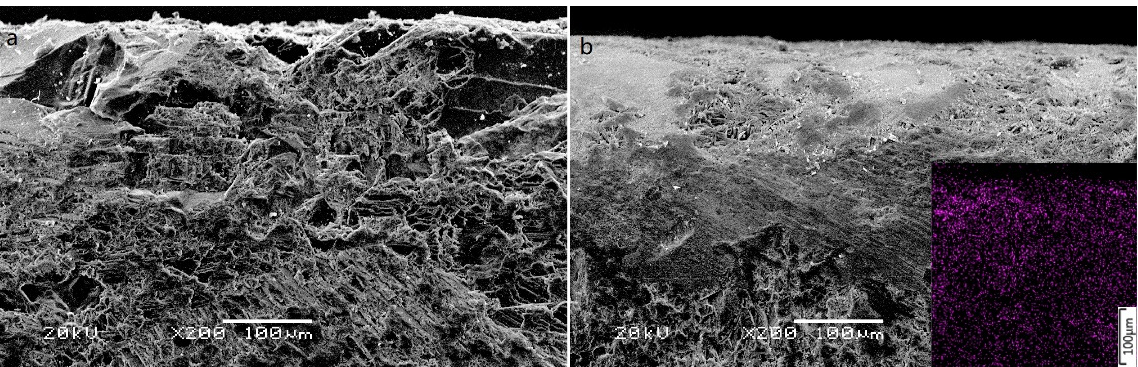
Figure 8. The cross–section of the bone samples. ( a ) Untreated, ( b ) consolidated by CSD.